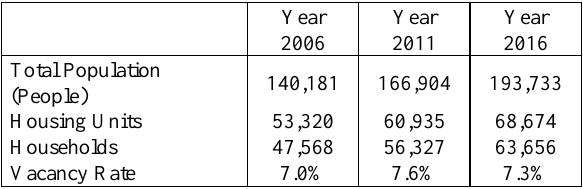
Table 2 . Demographic trends in